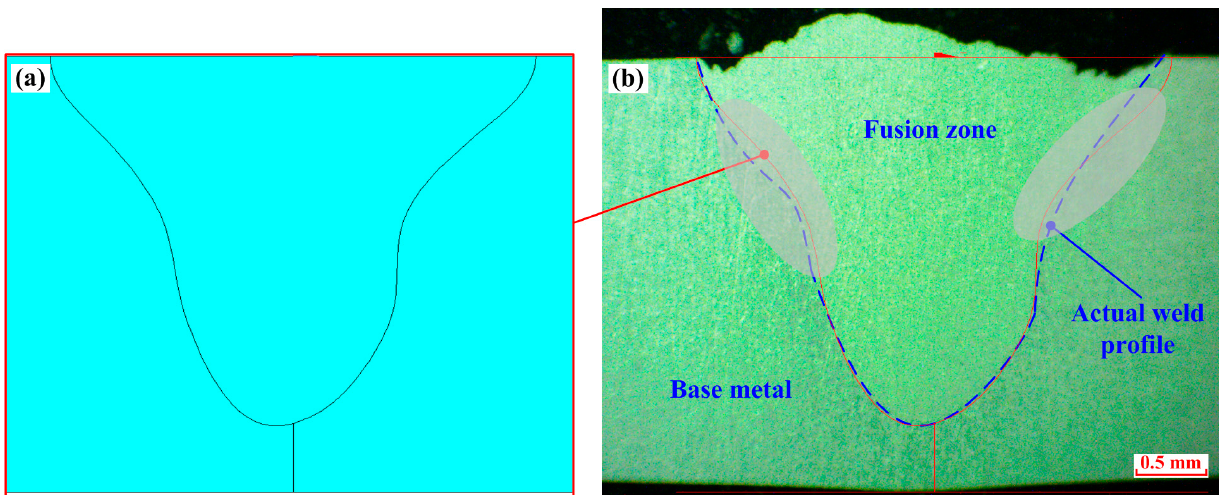
Figure 6. Microstructure of Al 6061 in laser welding: ( a ) near the fusion line, ( b ) heterogeneous nuclei [31].